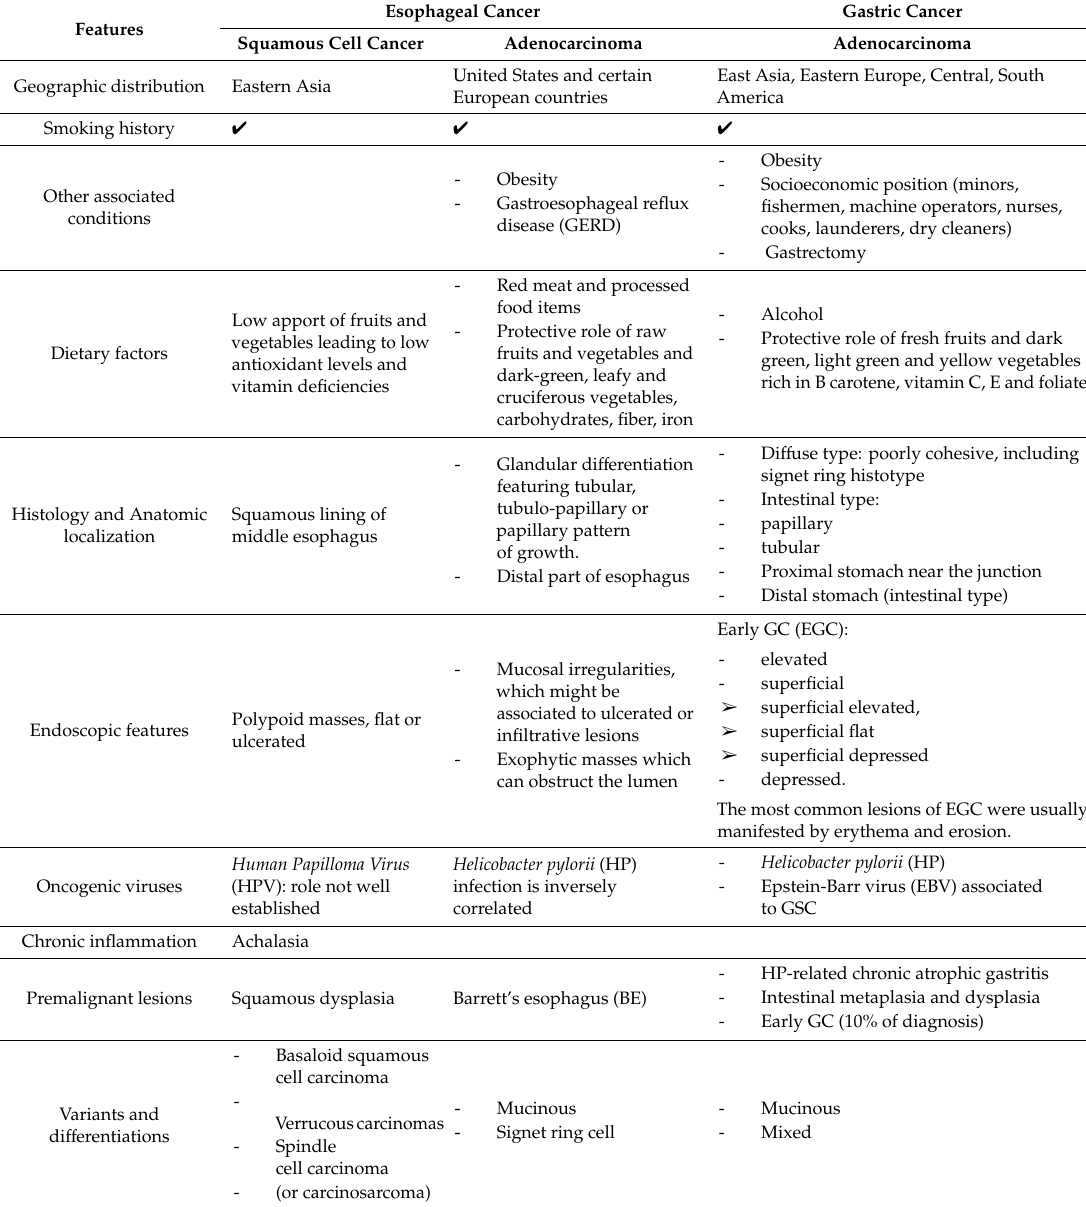
Table 2. Clinical, anatomic, pathologic and imaging characteristics of upper GI cancers. Main